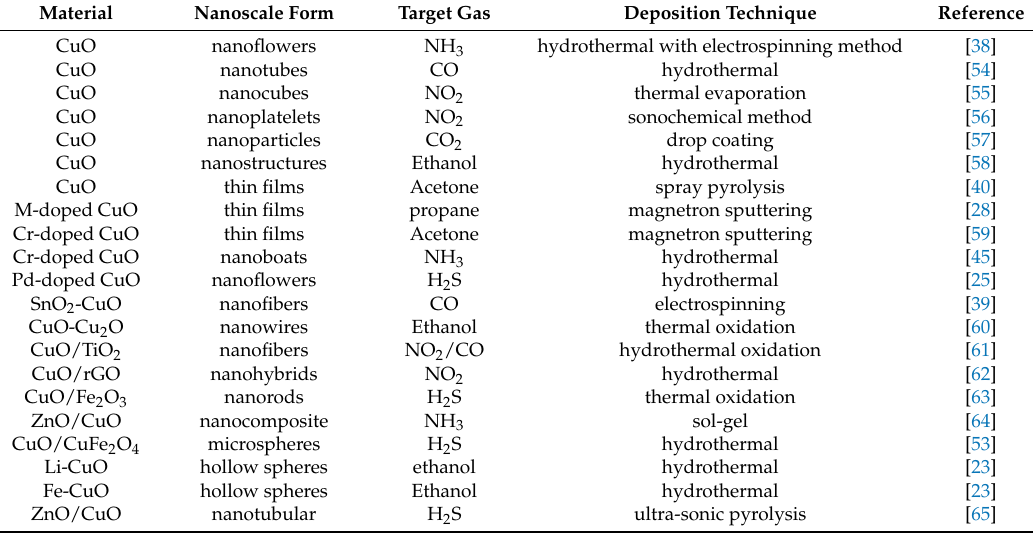
Figure 2. The copper oxide deposition methods: ( a ) Thermal evaporation (Reprinted with permission from [34]); ( b ) Magnetron sputtering (Reprinted with permission from [28]. Copyright 2017 Elsevier); ( c ) Hydrothermal method (Reprinted with permission from [37]. Copyright 2017 Elsevier); ( d ) Facile method (Reprinted with permission from [53]. Copyright 2018 Elsevier). Table 1. Selected information of various deposition techniques and nanoscale forms of CuO-based gas sensors presented in the paper.